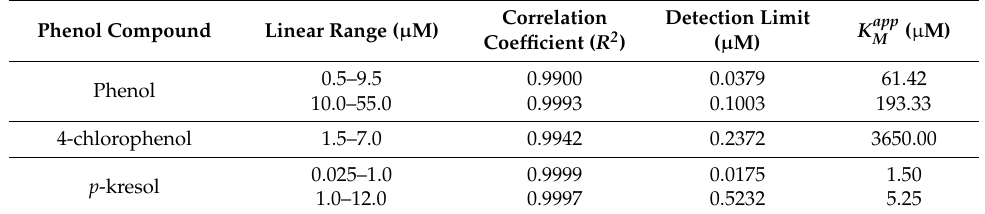
The response characteristics of the SPCE/CTAB/PEG/tyrosinase composite film to phenolic